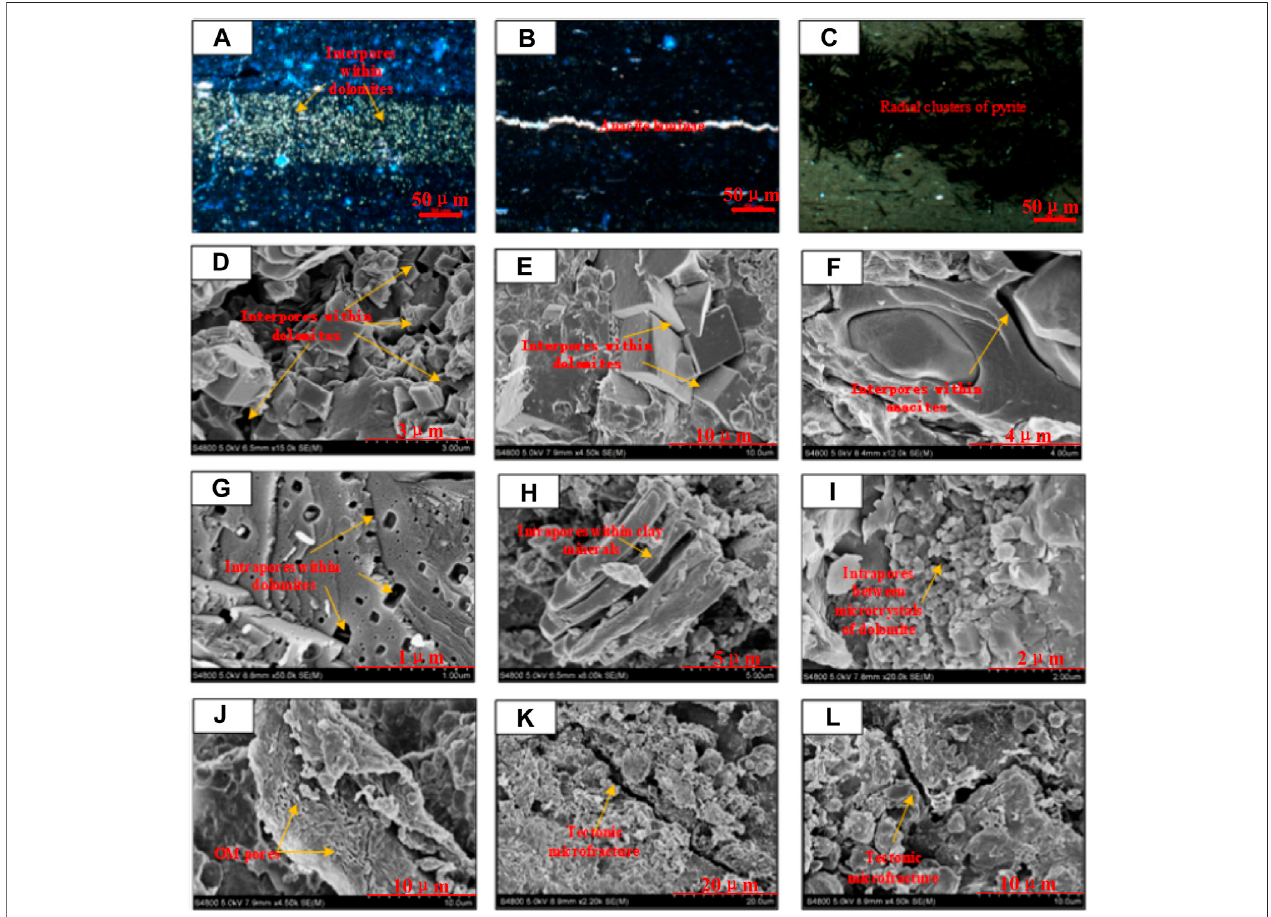
FIGURE 5 | Types of pores and morphology of shale samples under FE-SEM.